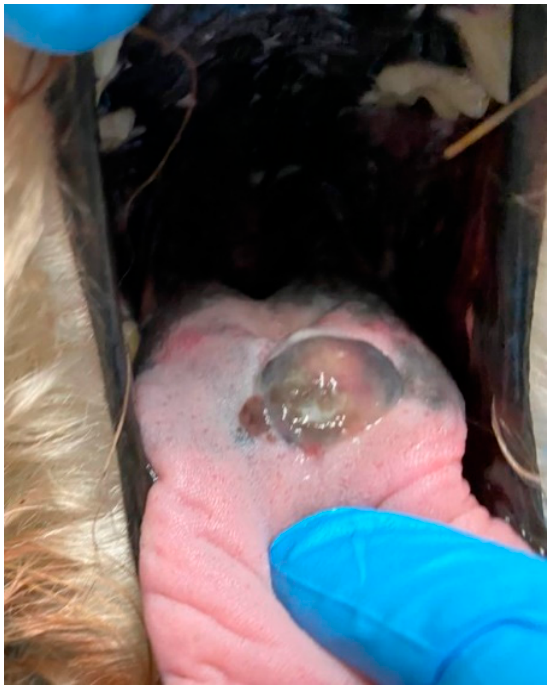
Figure A1. The mass at presentation to the QVSH.